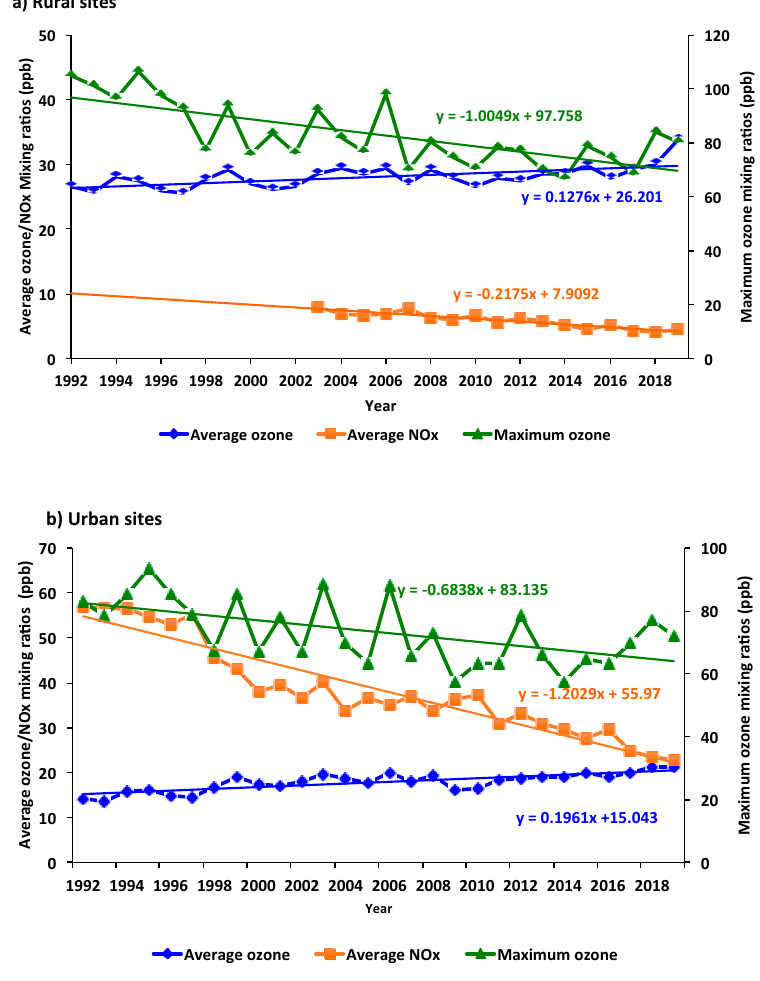
Figure 2. The mixing ratios of yearly average ozone, average NO X and maximum ozone for ( a ) rural and ( b ) urban sites over the last 30 years. Note: The data points indicate the averages of all rural sites ( a ) and urban sites ( b ) of the yearly averaged data for the indicated time period. No available data for rural NO X from 1992 to 2002. Trends are based on linear regression fitting with 95% confidence intervals and p values.